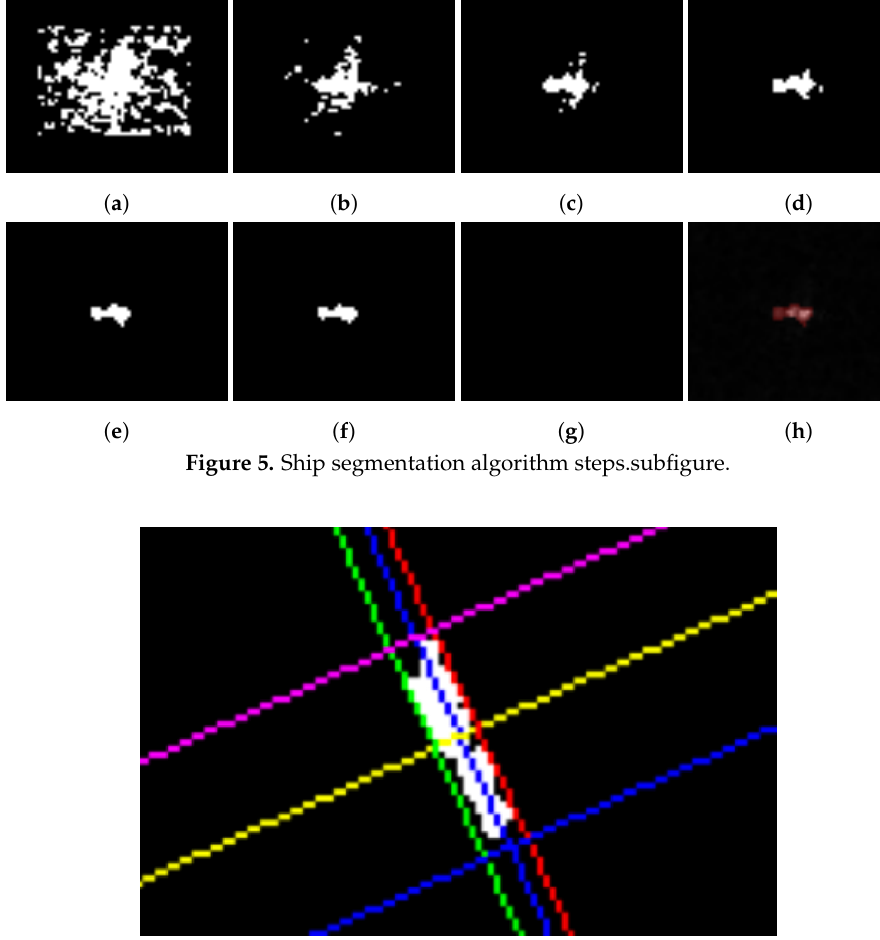
Figure 6. Result of the ship segmentation algorithm applied to the SAR image crop in Figure 4. The principal inertia axes and enclosing rectangle are highlighted in